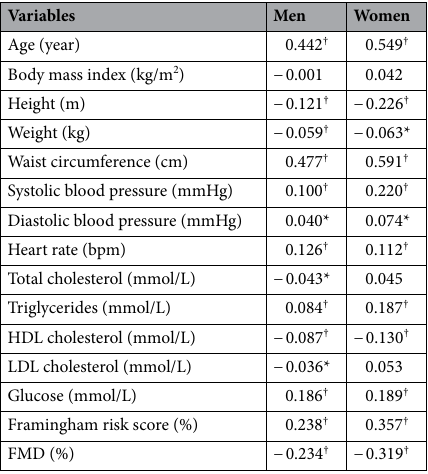
Table 2. Pearson’s correlation coefficients analysis of relationships between a body shape index and variables. HDL high-density lipoprotein, LDL low-density lipoprotein, FMD flow-mediated vasodilation. Pearson’s correlation coefficients analysis of the relations between a body shape index and variables. *P < 0.001. † P < 0.0001.